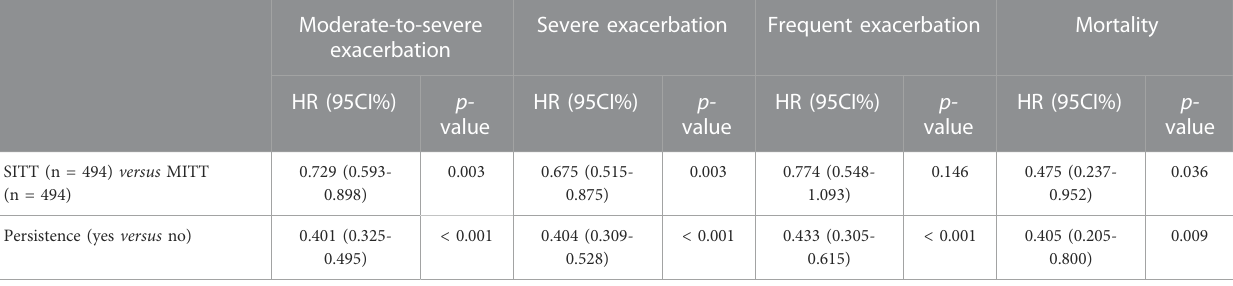
TABLE 4 Risk of different inhaler triple therapy and treatment persistence for future exacerbation and mortality during 1-year follow-up using Cox regression after PSM.